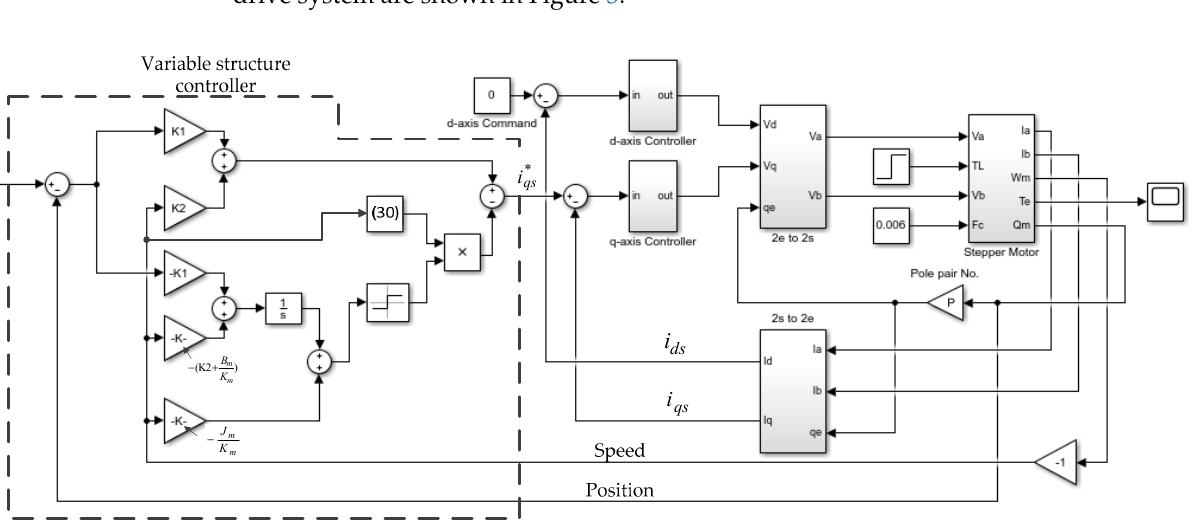
Figure 4. The position command and speed command profiles. In (31),